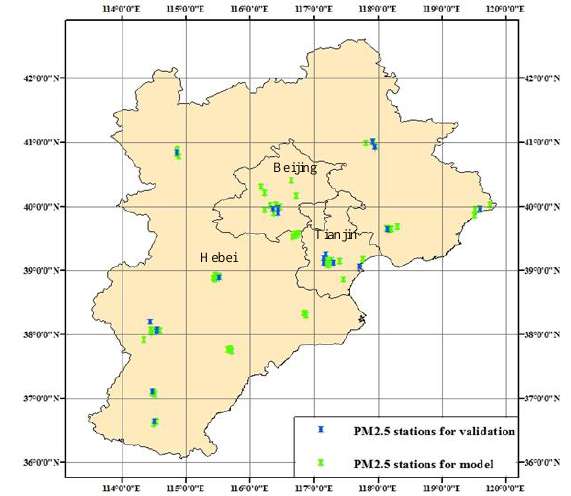
Figure 1. Spatial distribution of ground monitoring PM 2.5 stations (green pin for model calibration, blue pin for validation of the